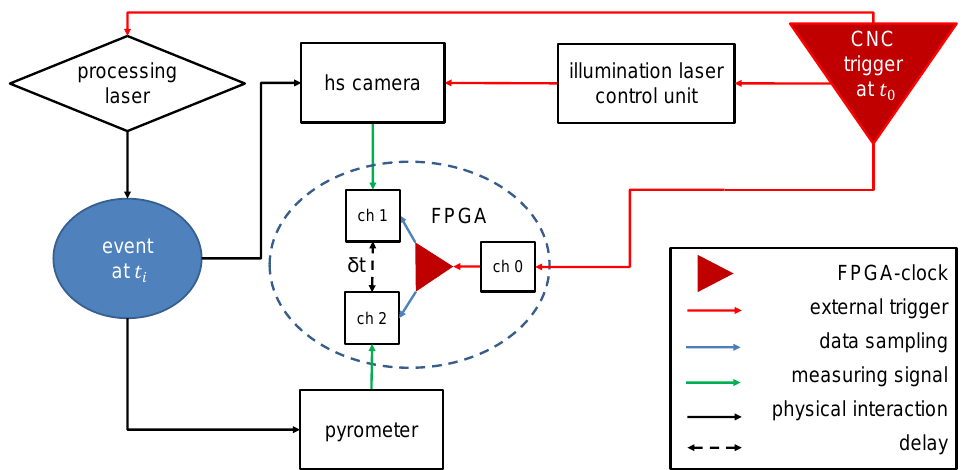
Figure 8. Schematic of the signal paths in the experimental setup.